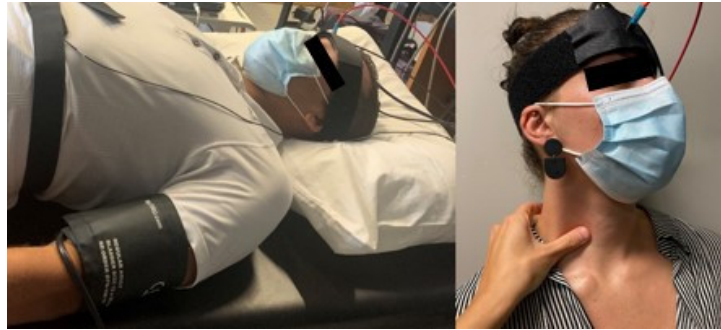
Figure 2. Experimental participant set-up and carotid compression (CC) procedure.